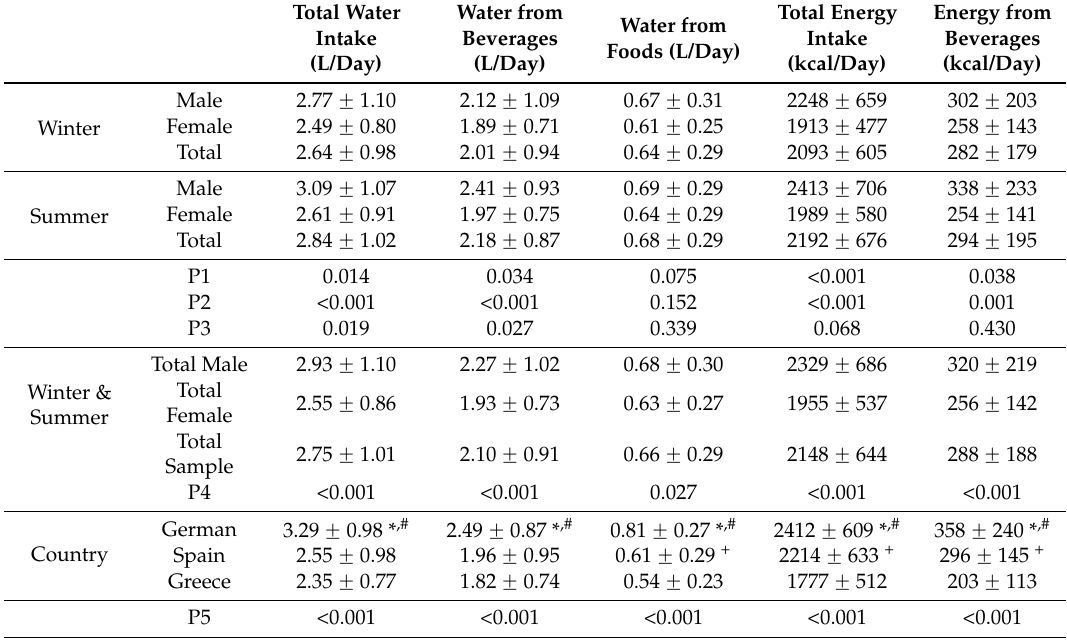
Table 3. Daily intake of water from all sources, from beverages and foods, separately of participants in winter and summer periods.